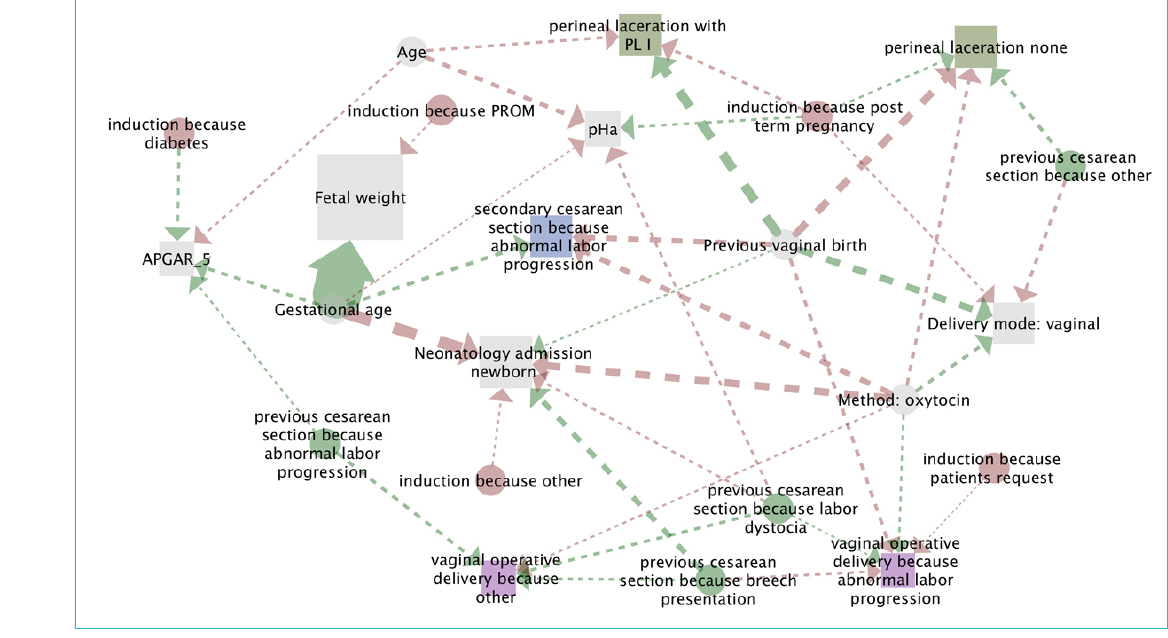
Figure 2: All significant and multiple correlations in the cohort. (Induction method catheter and oxytocin after caesarean section; for de- tails see table 3 – clinically significant correlations and table S1 – clinically not relevant correlations). Each edge represents a statistically sig- nificant relationship between multiple variables. Positive correlations are indicated by the colour green (for example, previous vaginal birth in- creases the likelihood of vaginal delivery and a first degree perineal tear). Negative correlations are indicated by the colour red (for example, previous vaginal birth decreases the likelihood of secondary CS and vaginal assisted delivery due to abnormal labour progression). Predictive variables (factors) are indicated with circles and outcome variables with squares (for example higher gestational age results in increased fetal weight and higher risk for secondary CS due to abnormal labour progression). The size of the squares reflects the overall significance. Finally, variables related to the same indication or outcome variable (each reason for induction or type of perineal laceration) have the same node